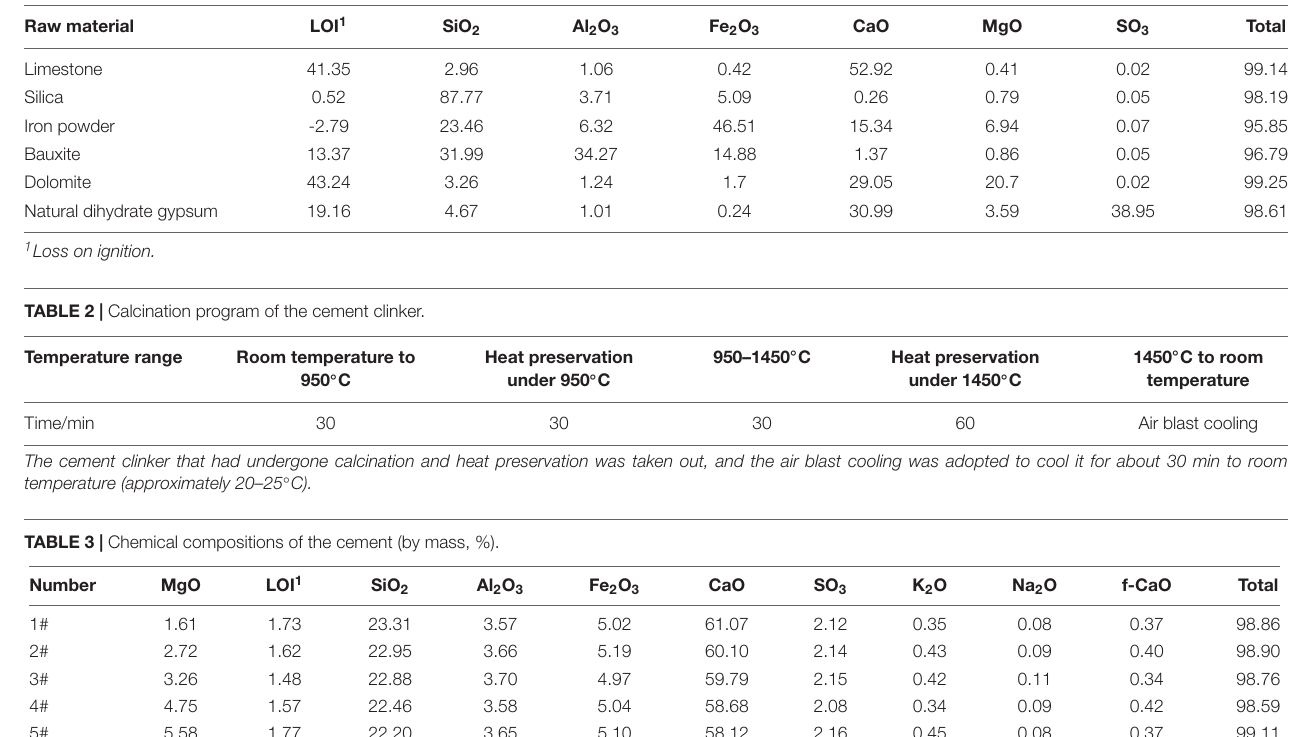
TABLE 1 | Chemical compositions of raw materials (by mass, %).